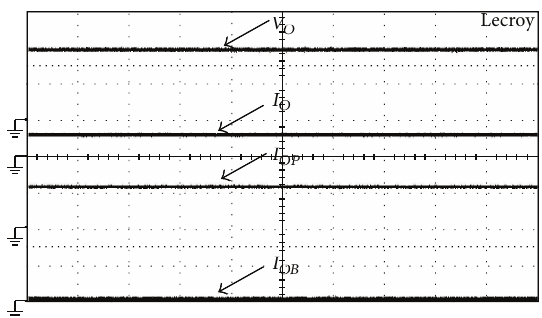
Figure 18: Measured voltage 𝑉 𝑂 , current 𝐼 𝑂𝐵 , 𝐼 𝑂𝑃 , and 𝐼 𝑂 waveforms of the proposed PV power conversion system using the single- capacitor snubber operated in mode VIII under (𝑃 𝑃( max ) +𝑃 𝐵( max ) ) ≥ 𝑃 < 𝑃 𝑃 𝐿 and 𝐿 PV ( max )